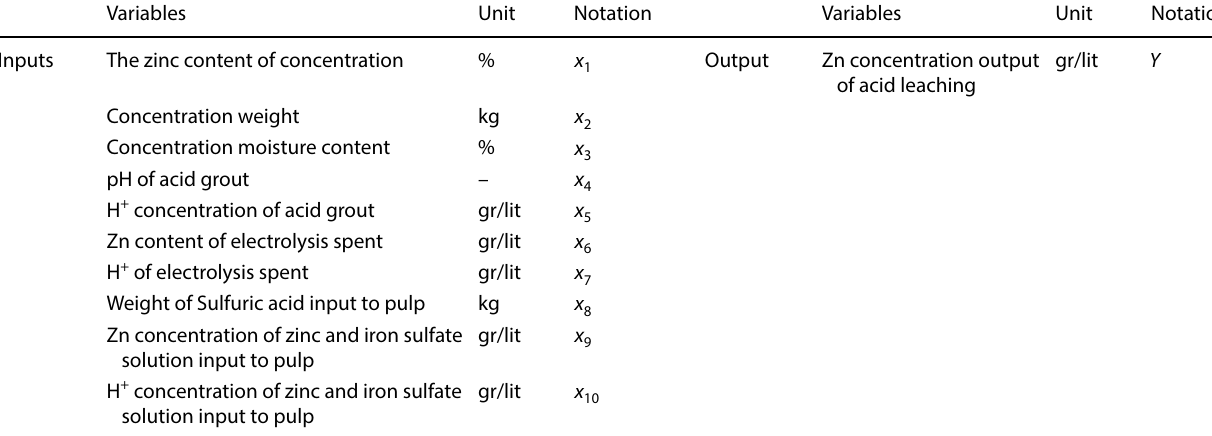
Table 5 Inputs and outputs notations